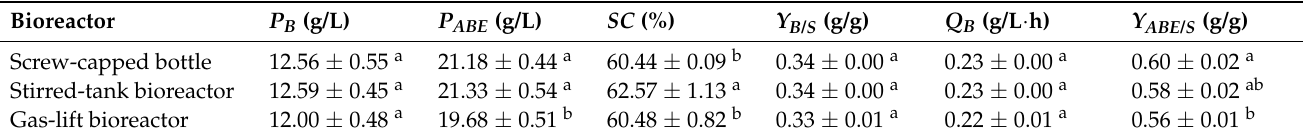
Figure 6. Profiles of pH ( a ), acetic acid ( b ), butyric acid ( c ), total acids ( d ), total sugar ( e ), acetone ( f ), butanol ( g ), ethanol ( h ) and ABE concentrations ( i ) during batch ABE fermentation by the mixed cultures in screw-capped bottles ( ○ ), stirred-tank bioreactor ( ☆ ) and gas-lift bioreactor ( □ ). Table 2. Kinetic parameters of ABE fermentation by the mixed cultures of C. beijerinckii TISTR 1461 and Arthrobacter sp. BCC 72131 (inoculating C. beijerinckii after 6 h of Arthrobacter cultivation) in various bioreactors after 54 h of fermentation.